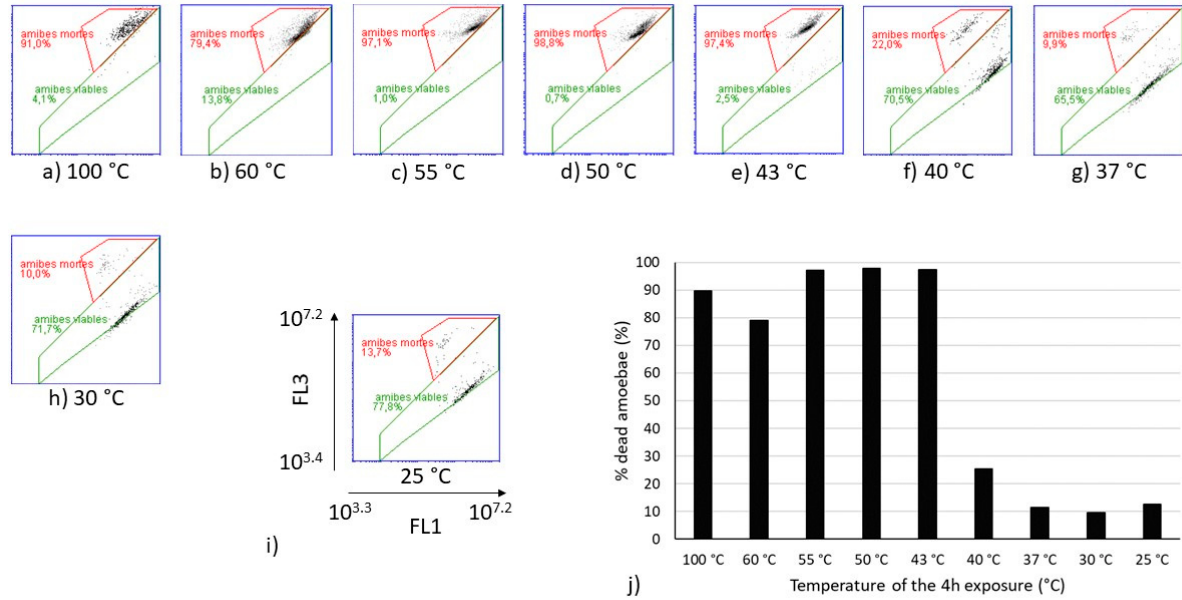
Figure 3. Cytograms of heat-treated V. vermiformis samples with SYBRGreen I and Propidium iodide (SGPI) staining ( a – h ), and evolution of the percentage of dead V. vermiformis depending on the temperature of the 4 h treatment ( j ). ( i ) is a zoom on one of the cytograms with the specification of the scales of the axes. The gate in red dot lines delimited the population of dead amoebae. “amibes mortes” means dead amoebae and “amibes viables” means viable amoebae. For the percentages indicated on the cytograms, a comma separates the decimals.